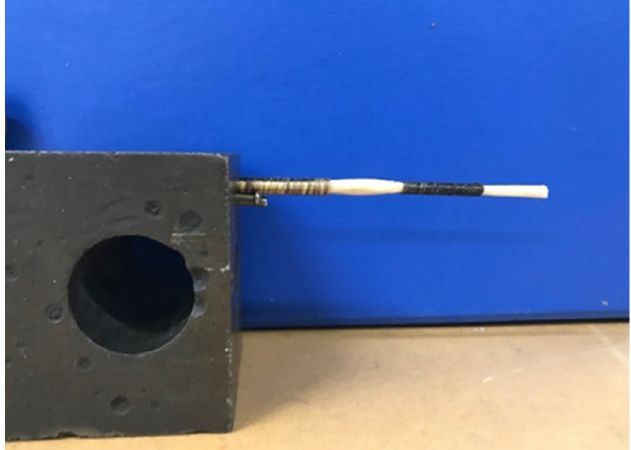
Figure 3. Arrow assembly mounted for impact testing. Though all components of the assembly are present, to ensure head-on impact (minimised possibility for angular force), we shorten the main reed shaft and halve the length of the